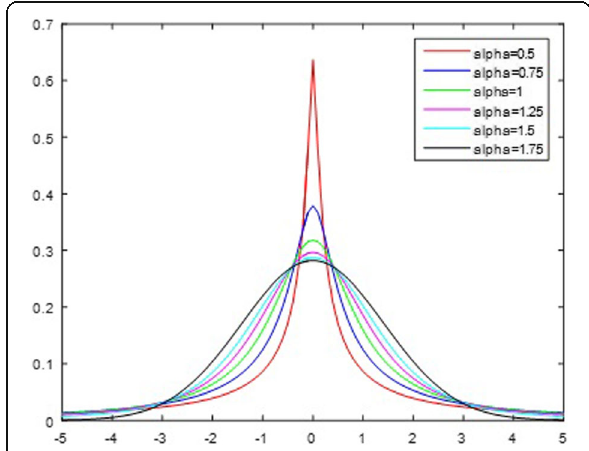
Fig. 4 Alpha-stable distribution for different values of